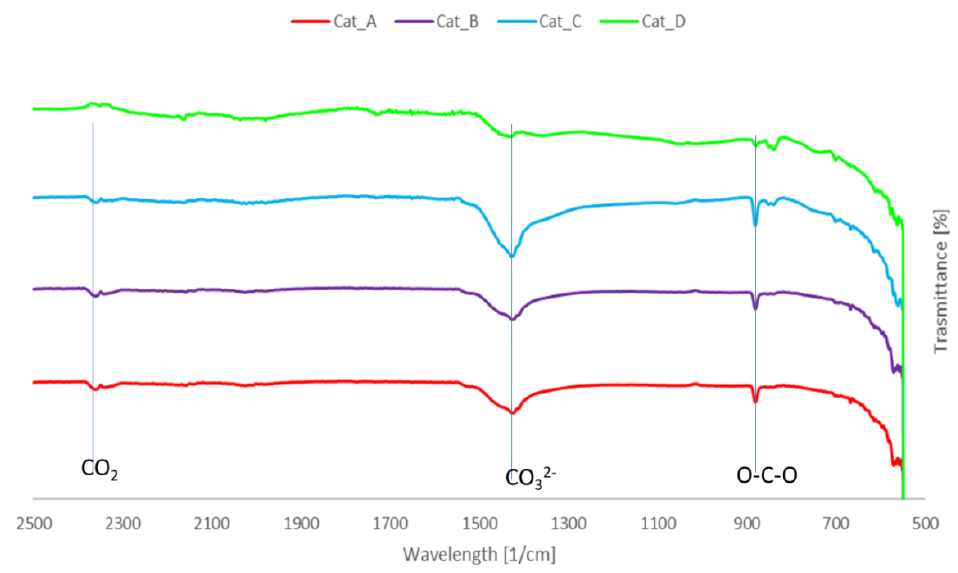
Figure 5. FTIR spectra of the spent catalytic mixtures.